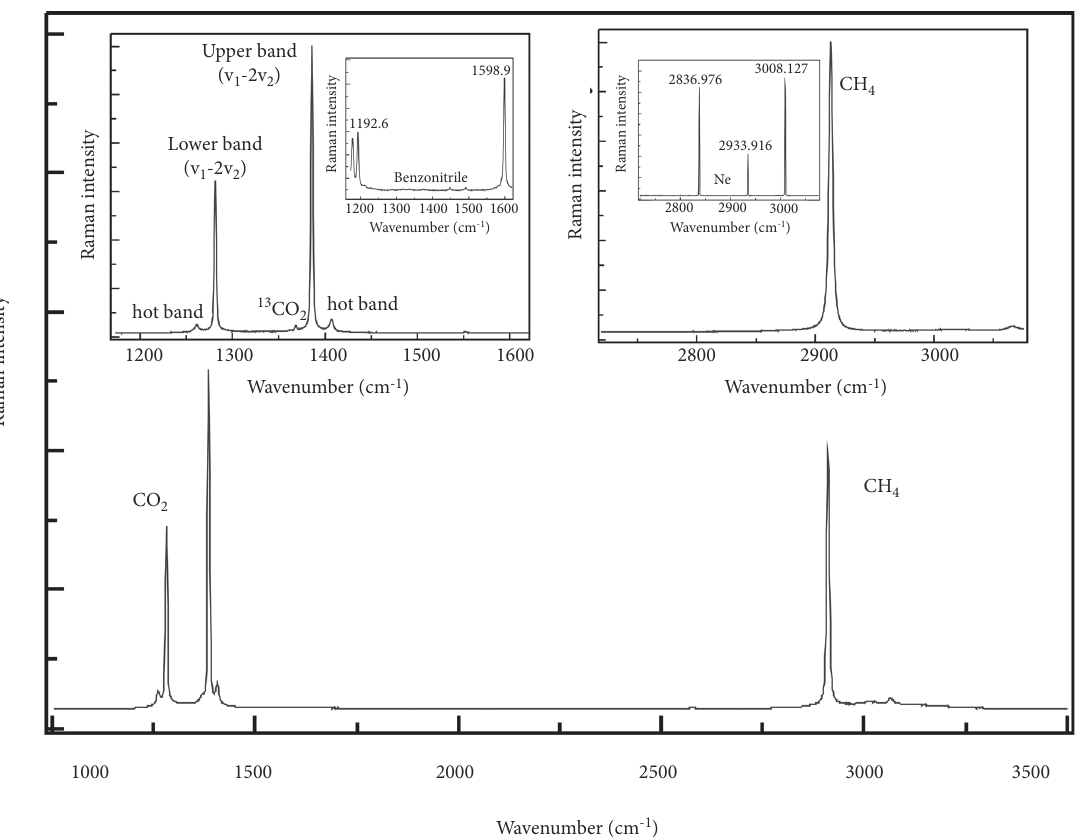
Figure 2: Raman spectrum of the CO 2 -CH 4 mixture showing the Raman lines for CO 2 and CH 4 . The top left insert shows the detailed spectrum of CO 2 containing Fermi diad bands, two hot bands, 13 CO 2 , and the spectrum for benzonitrile. The two marked peaks for benzonitrile (1192.6 and 1598.9cm − 1 ) were used to calibrate the CO 2 Fermi diad splitting. The right insert shows the C-H symmetric υ 1 band of CH 4 and Ne emission lines at 2836.976 cm − 1 , 2933.916cm − 1 , and 3008.127cm − 1 . The Ne emission lines at 2836.976 cm − 1 and 2933.916cm − 1 bracket the υ 1 band of CH 4 and were used to calibrate the CH 4 υ 1 peak